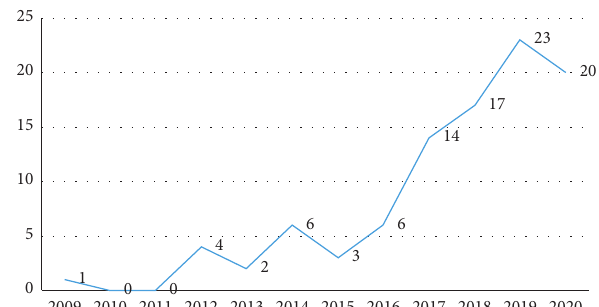
Figure 4: Annual distribution of the number of graduation theses by masters and PhDs.